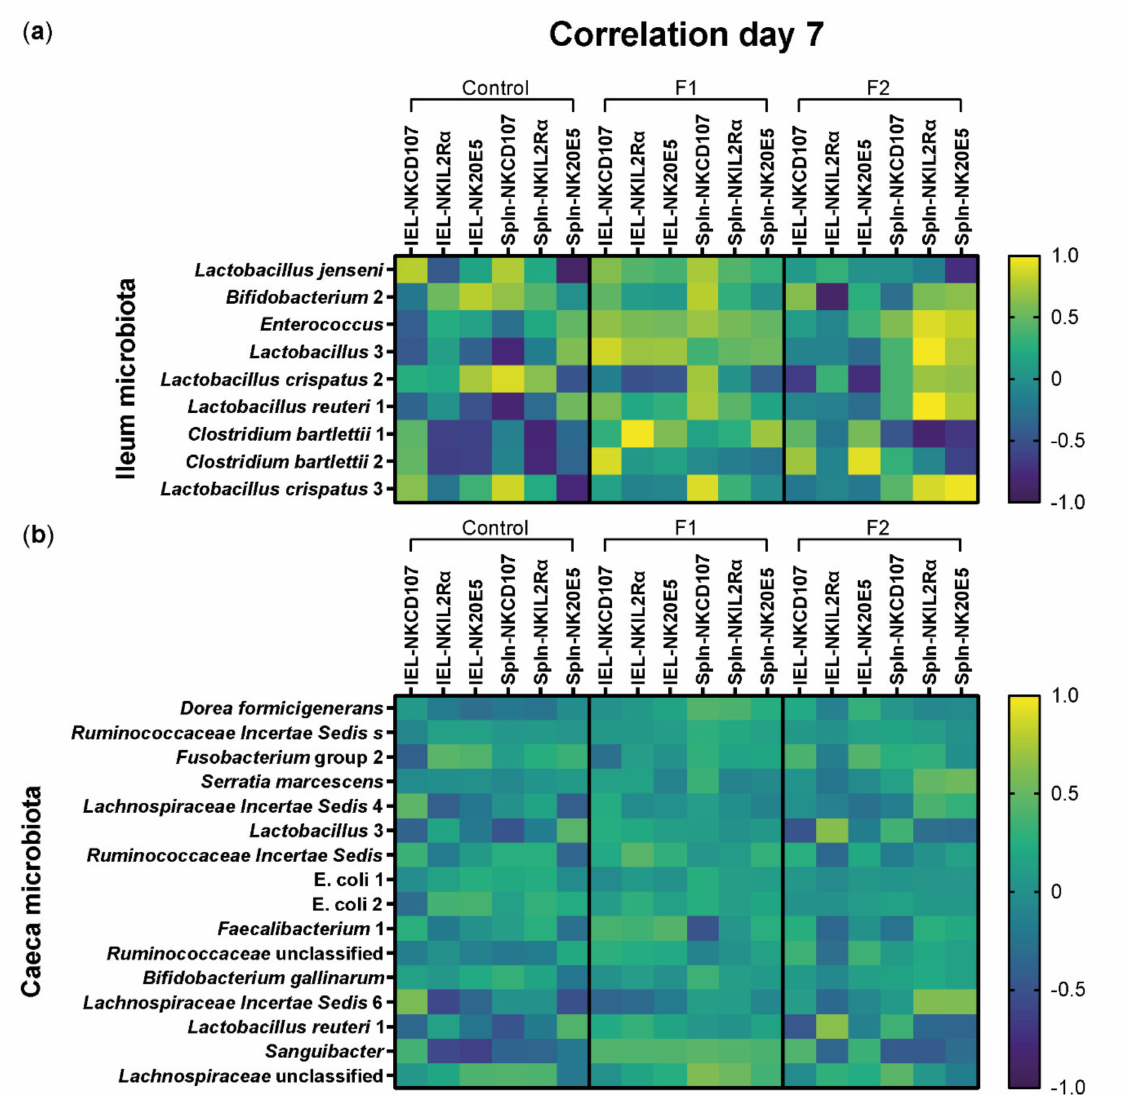
Figure 7. Correlations between intestinal microbial taxa and intraepithelial and splenic NK cells at day 7 in broiler chickens. ( a ) Correlation values between microbial taxa in the ileum or ( b ) ceca significantly increased with the respective feed and percentages of NK cell activation or numbers of NK cell subsets of the ileum (IELs) and spleen (Spln) per diet group (control, F1, F2) at day 7 in broiler chickens. Pearson’s correlation (r) values are depicted in a heatmap as positive (yellow) or negative (dark blue)